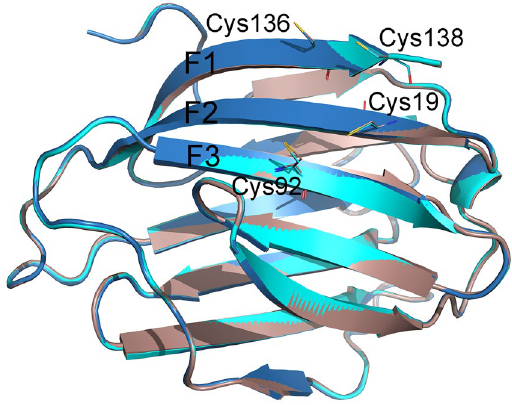
Figure 7. The positions of Cys19, Cys92, Cys136, and Cys138. WT Gal-13 is colored deep blue; the two R53H structures are colored cyan and